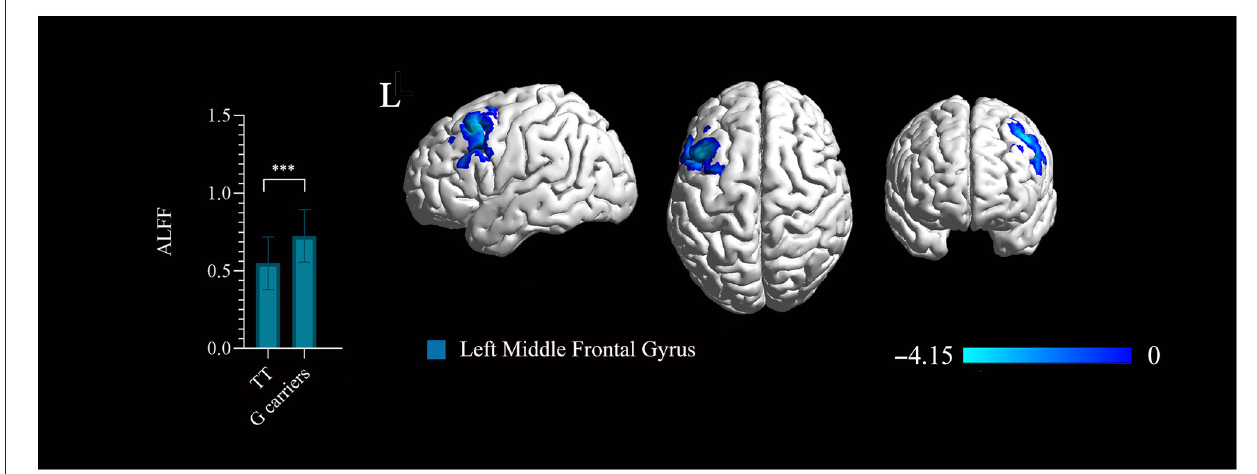
FIGURE 3 | Significant regions mapped onto the standard Ch2 Template using BrainNet Viewer. The rs1781735 genotype effect on the amplitude of low-frequency fluctuation (ALFF) map in the patients (TT genotype > G carriers). Areas colored blue gradient correspond to the t -value. ***, P < 0.001, familywise error (FWE) corrected. The error bar represents the SD of the